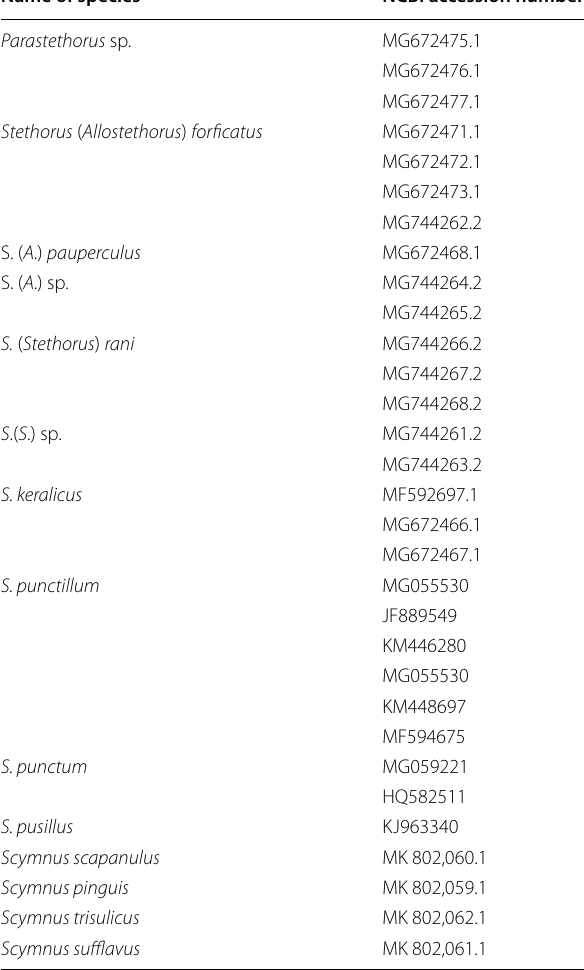
Table 1 Sequences used for phylogenetic analysis